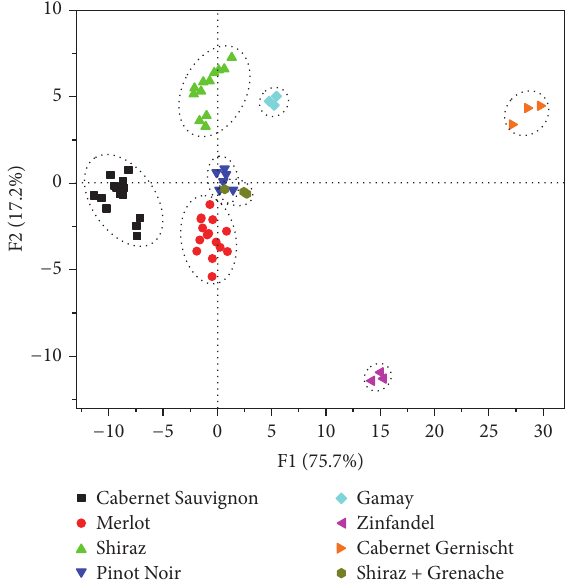
Figure 3: LDA plot for the discrimination of the wine variety based on the organic acid profiles (20 samples × 6 variables × 3